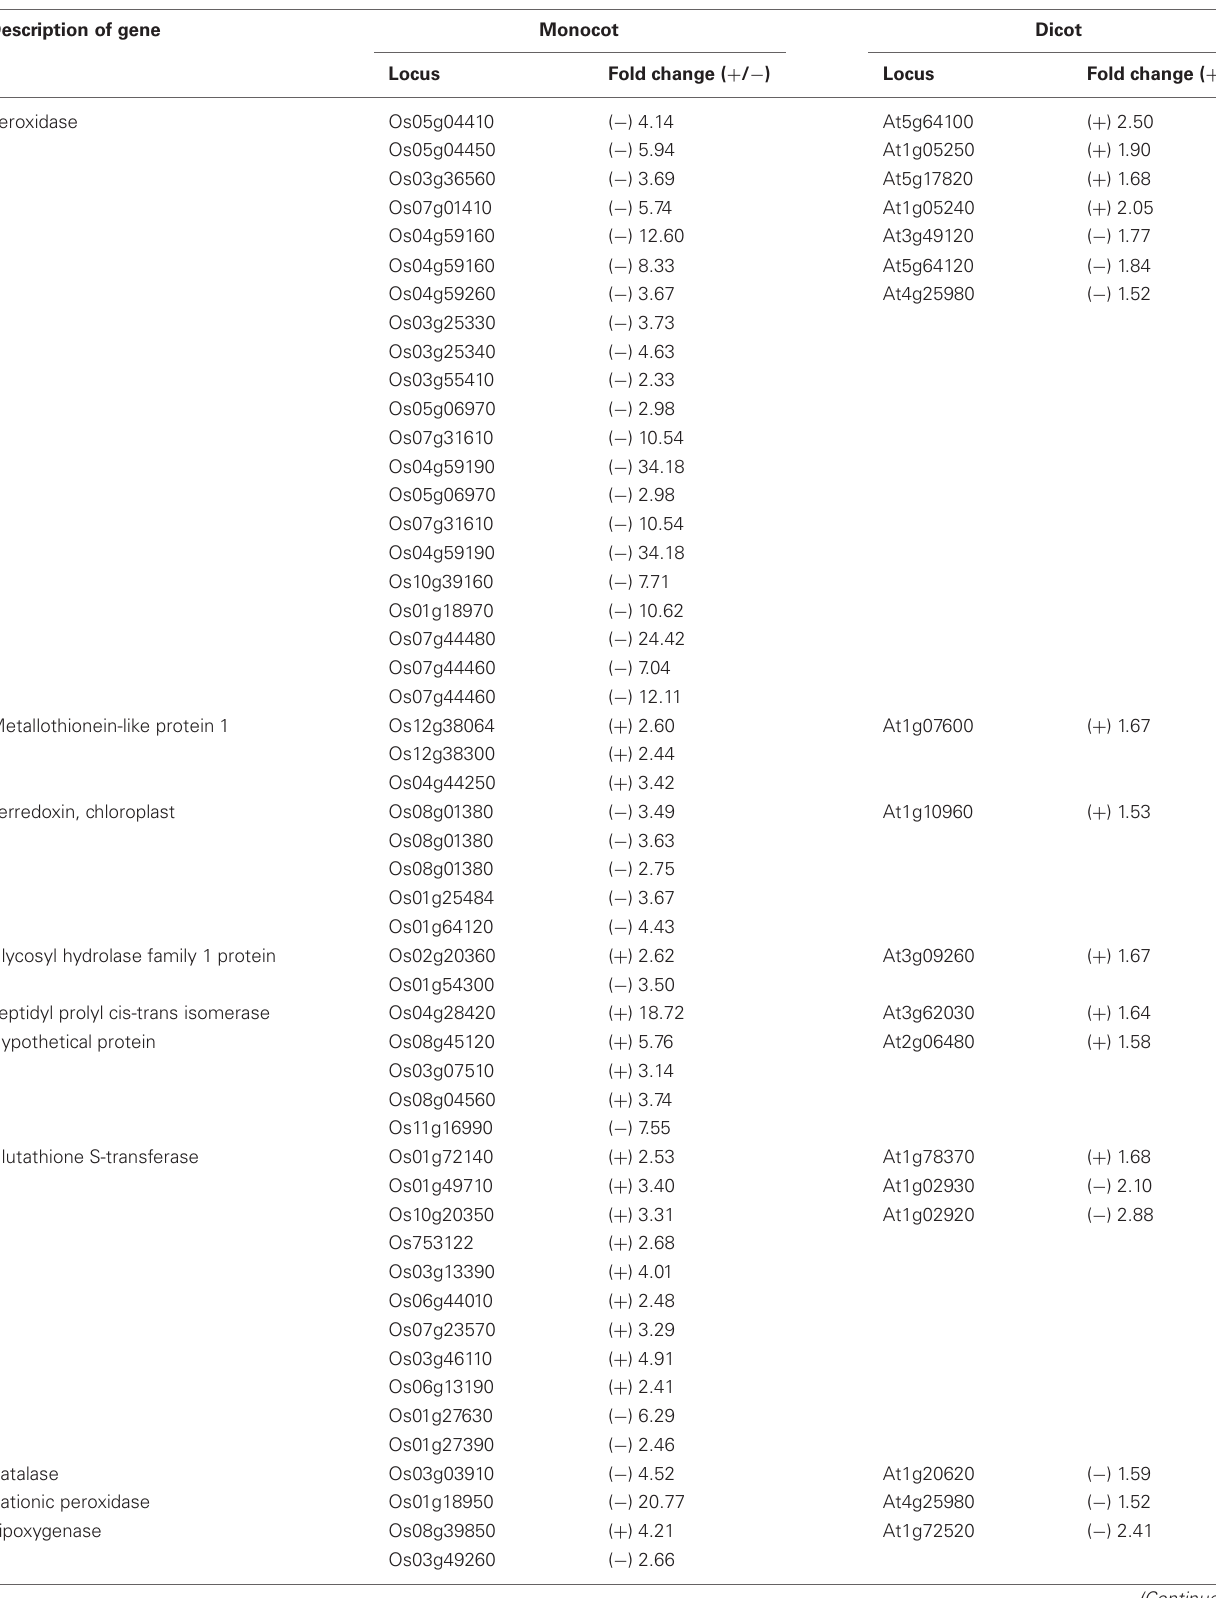
Table 1 | Sets of differentially regulated genes in monocot ( O. sativa ) and dicot ( A. thaliana ) plants during “As”